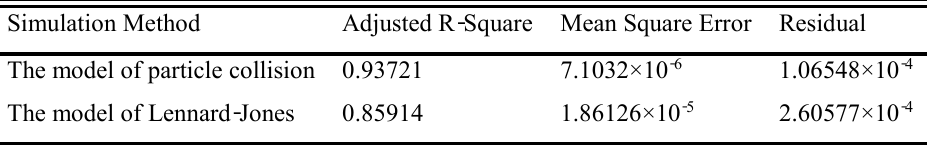
The error value of nonlinear fitting.